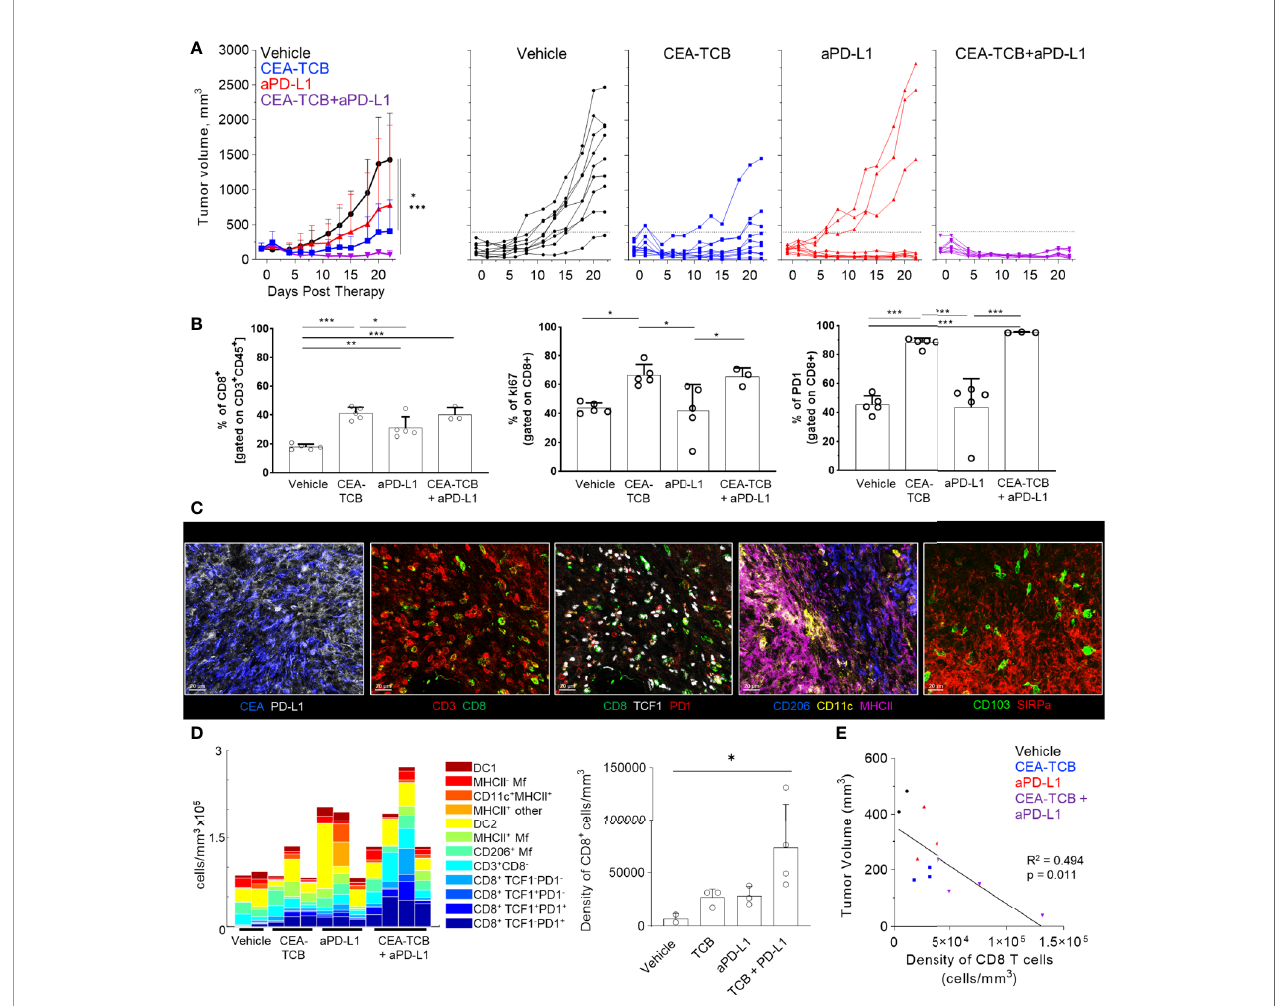
FIGURE 1 | Ef fi cacy of CEA-TCB and anti PDL-1 therapeutic interventions in MC38-CEA tumors. MC38-CEA tumor-bearing mice were treated with the indicated immunotherapies when tumors ranged ~100-300mm 3 in volume. Treatment regimens were continued in 3d intervals for CEA-TCB and combination, and 7d intervals for aPD-L1. (A) Average tumor volume for each group (left), tumor volumes for each sample and treatment (right) after start of treatment. Pooled data from 2 independent experiments (n= 9/group). One-Way ANOVA with Dunnett ’ s multiple comparison test. (B) Frequency of CD8 T cell among all T cells (left), the percentage of Ki-67 + (center) and PD-1 + CD8 T cells (right) in each treatment group as determined by fl ow cytometry at study end point (22d post start of treatment, n=5/group). One-Way ANOVA with Tukey ’ s multiple comparison test. (C) Multiplex confocal images highlighting markers used to phenotype immune cells in MC38- CEA tumors. Scale bars are 50 µm. (D) Average density of immune cell populations for individual tumor samples (columns) per imaged volume (left) and CD8 T cell density across different groups (right), as identi fi ed via histocytometry. One-Way ANOVA with Dunnett ’ s multiple comparison test. (E) Correlation between the tumor volume and density of CD8 T cells identi fi ed by histocytometry. Tumor growth curves and harvest points for data in (C – E) are displayed in Figure S1A . n=2 for control, n=3 for CEA-TCB and aPDL1 and n=4 for CEA-TCB+aPDL1 group. Data points represent individual tumor samples. Bar graphs show mean, and error bars represent standard deviation (SD). *p < 0.05, **p < 0.01, ***p <